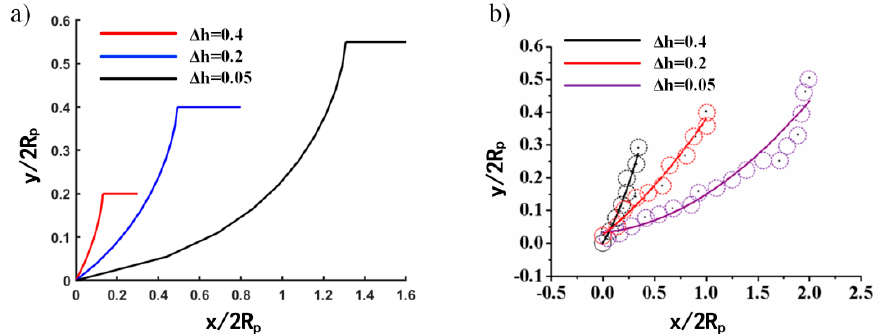
Figure 8. Theoretical ( a ) and experimental ( b ) microparticle trajectory with different offset, h .